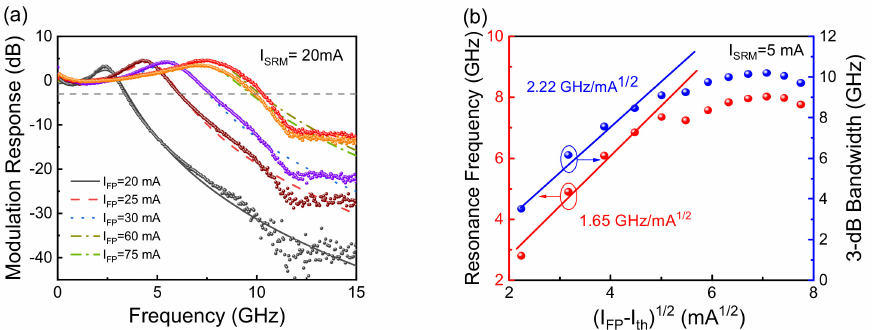
Figure 6. ( a ) Small-signal modulation responses of the HSRRL at the FP cavity biasing currents of 20, 25, 30, 60, and 75 mA and SRM biasing current of 20 mA. ( b ) The fitted relaxation resonance frequencies f R and 3 dB bandwidths versus the square root of the bias current minus the threshold current.